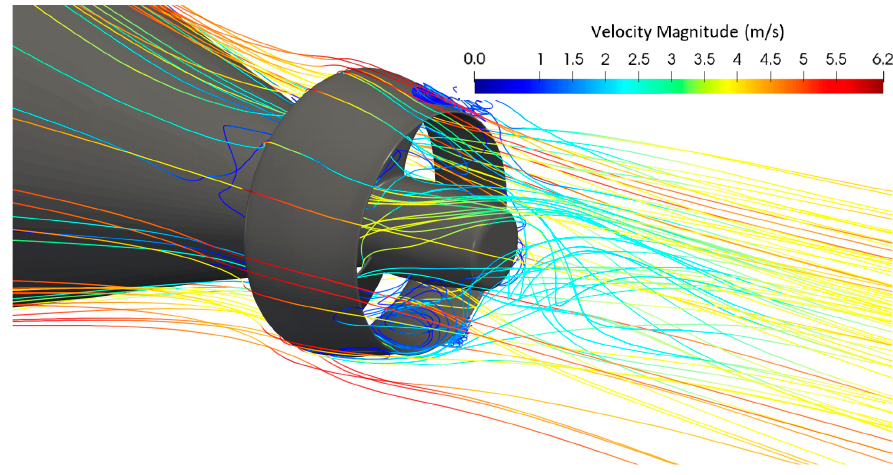
Figure 15. Streamlines around the propeller shroud colored by the flow velocity magnitude.